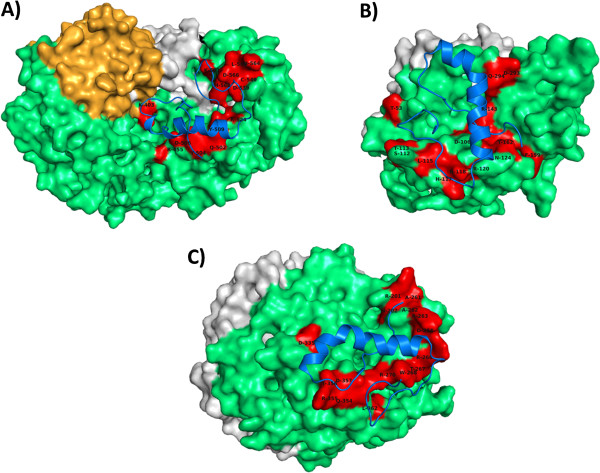
Prt/ZP predicted binding. (A) Prt/ZP2 model; (B) Prt/ZP3 model; (C) Prt/ZP4 model. ZPs and Prt are shown respectively in surface and cartoon representations. Residues 36–150 of bovine ZP2 are colored in orange. ZP2 (36–635), ZP3 (23–346) and ZP4 (18–461) chains, are colored in light green. Polar contacts are colored in red (corresponding ZP aminoacids are indicated with one-letter code). N-terminal signal peptide, and C-terminal propeptide (both removed in mature form), are colored in light gray. Ovine Prt model (cartoon) is colored in blue. Based on UniProtKB/Swiss-Prot sequences [Prt (A4ULE2); ZP2 (Q9BH10); ZP3(P48830); ZP4(Q9BH11)].